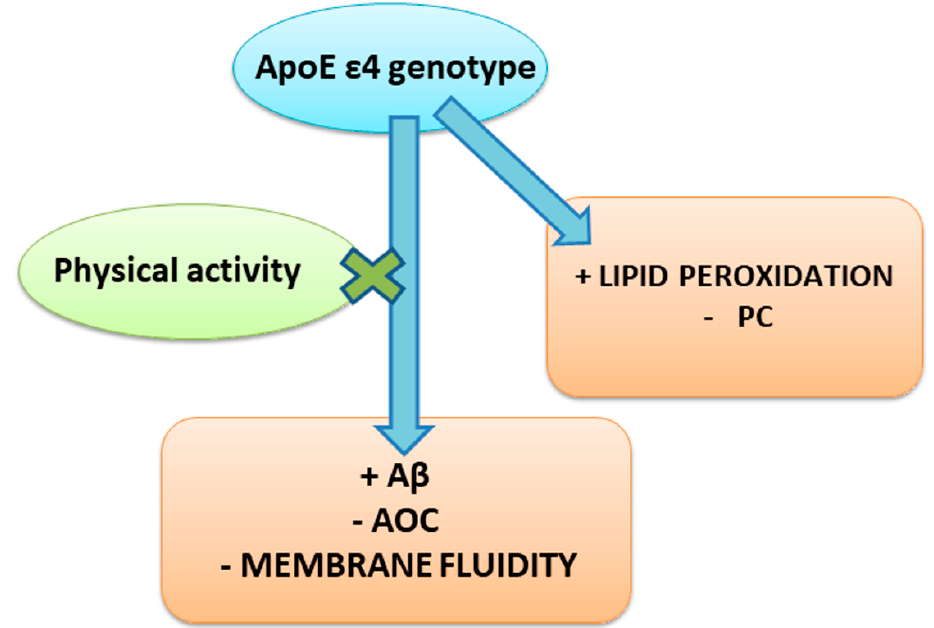
Figure 5. Modulation of the A β contents, oxidative status, and membrane’s composition of erythrocytes by ApoE polymorphism and physical activity. The presence of the ApoE ε 4 genotype enhances A β levels and lipid peroxidation, and decreases plasma AOC, membrane fluidity, and PC amount in erythrocytes. Regular physical activity counteracts the negative effects exhibited by the ε 4 genotype on A β levels, plasma AOC, and membrane fluidity.